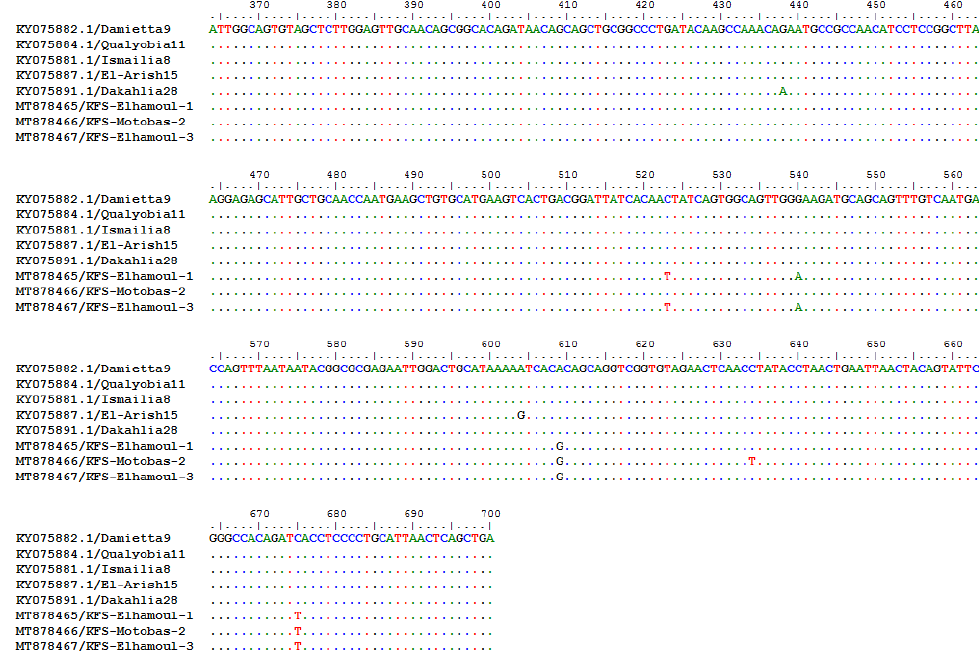
Figure 3. BioEdit Clustal W algorithm alignment of the Egyptian GVII 1.1 strain’s nucleotide sequences showed G609A and T675C nucleotide substitutions in our three identified strains, T523C and A540G nucleotide substitutions in KFS-Elhamoul-1 and KFS-Elhamoul-3 strains, and T634C nucleotide substitution in KFS-Motobas-2.